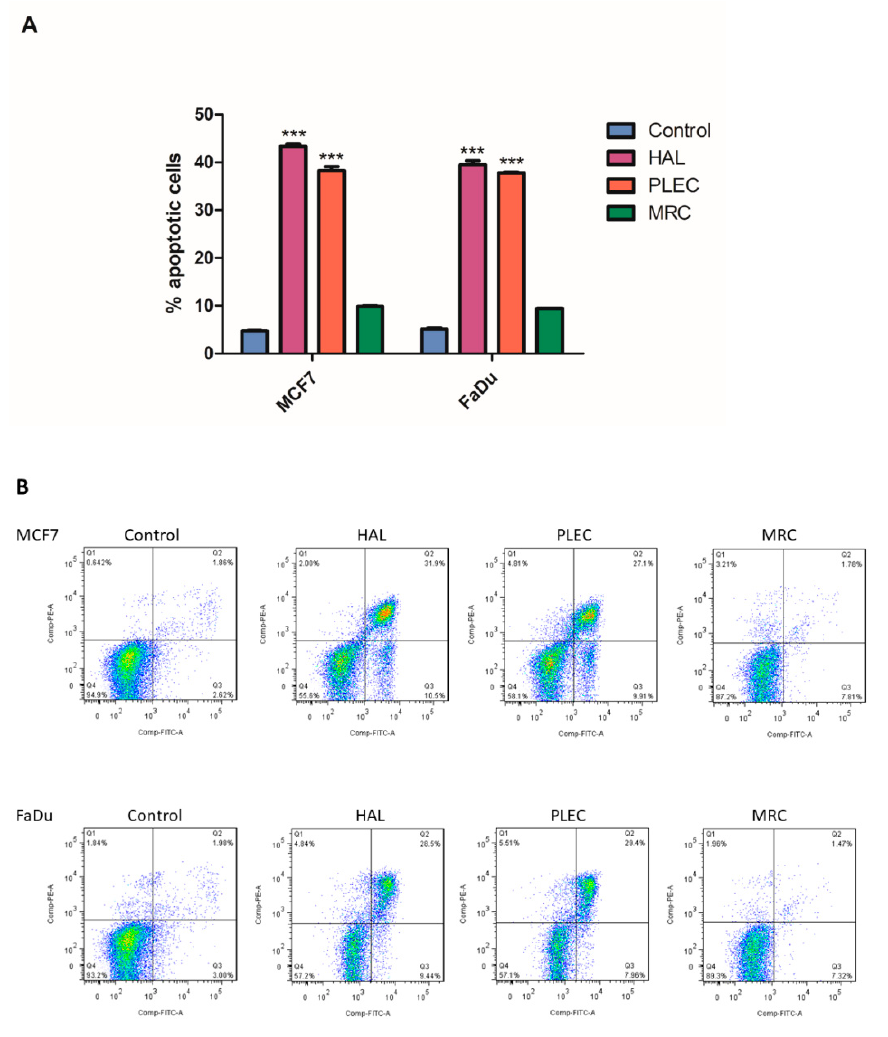
Figure 9. The effect of HAL, PLEC and MRC on apoptosis induction in MCF7 and FaDu cancer cells. Values are means ± SD (n = 3). *** p < 0.001 vs. control group (upper panel A ). The graph shows % apoptotic cells as the sum of cells in early and late apoptosis. The dot plots show (lower panel B ) results of one representative experiment for each kind of cells treated with HAL, PLEC, MRC. Q2 and Q3 quadrant presents a fraction of late and early apoptotic cells, respectively.